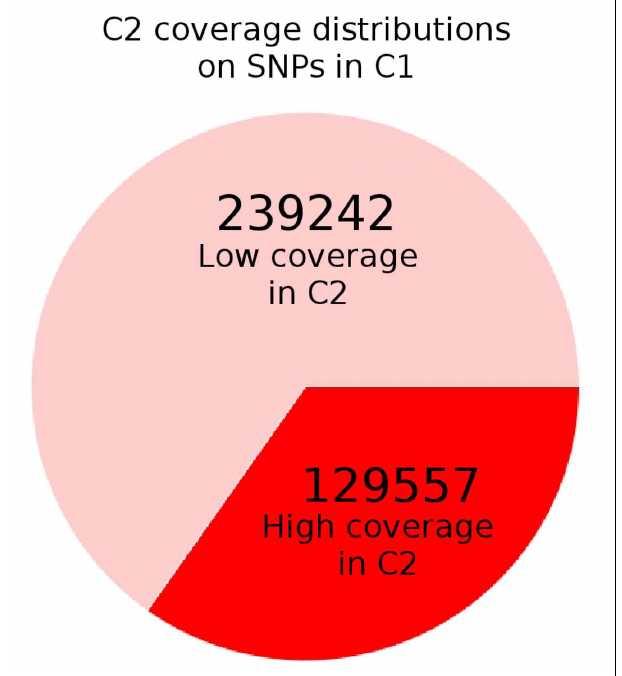
FIGUREA5 |The overlap between well-covered SNPs in control populations C1 and C2. For all sites labeled as variant with more than 10 × coverage in C1, we checked the corresponding coverage in C2. As can be seen, approximately 2/3 of these sites have “low” coverage of less than 10 × in C2, perhaps due to library biases in the latter. Since we set a 10 × minimum coverage threshold to ensure some level of precision on frequencies, these SNPs are not considered in C2. As a result, the π between term used in the directional F st is relatively underpowered. As the simulations showed that the powers of the statistics are fairly similar after fixation, we switched to S f for the Drosophila